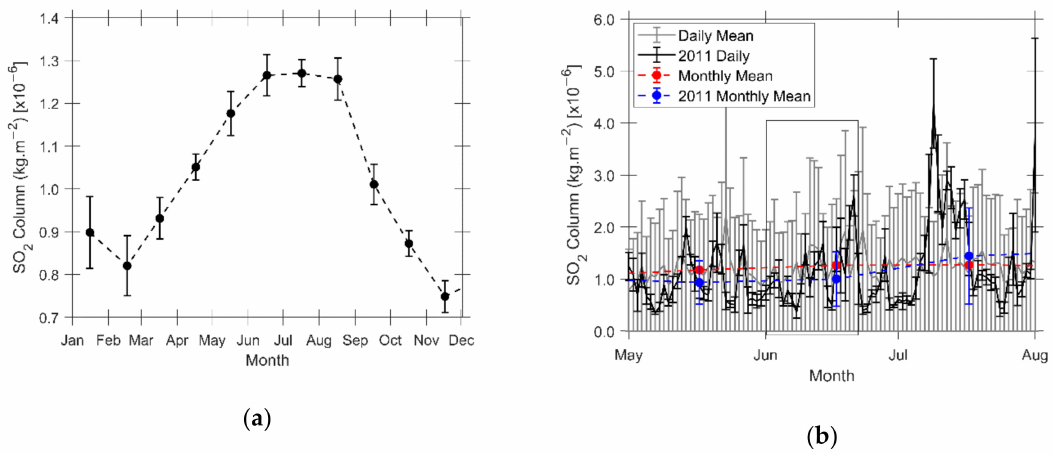
Figure 6. Monthly mean and ± 1 SD for each month (2007 − 2016) ( a ) and daily mean and ± 1 SD error bars during May–July 2011, with 10 − 20 June 2011 indicated in the rectangle ( b ) for SO 2 column from MERRA-2 at Cape